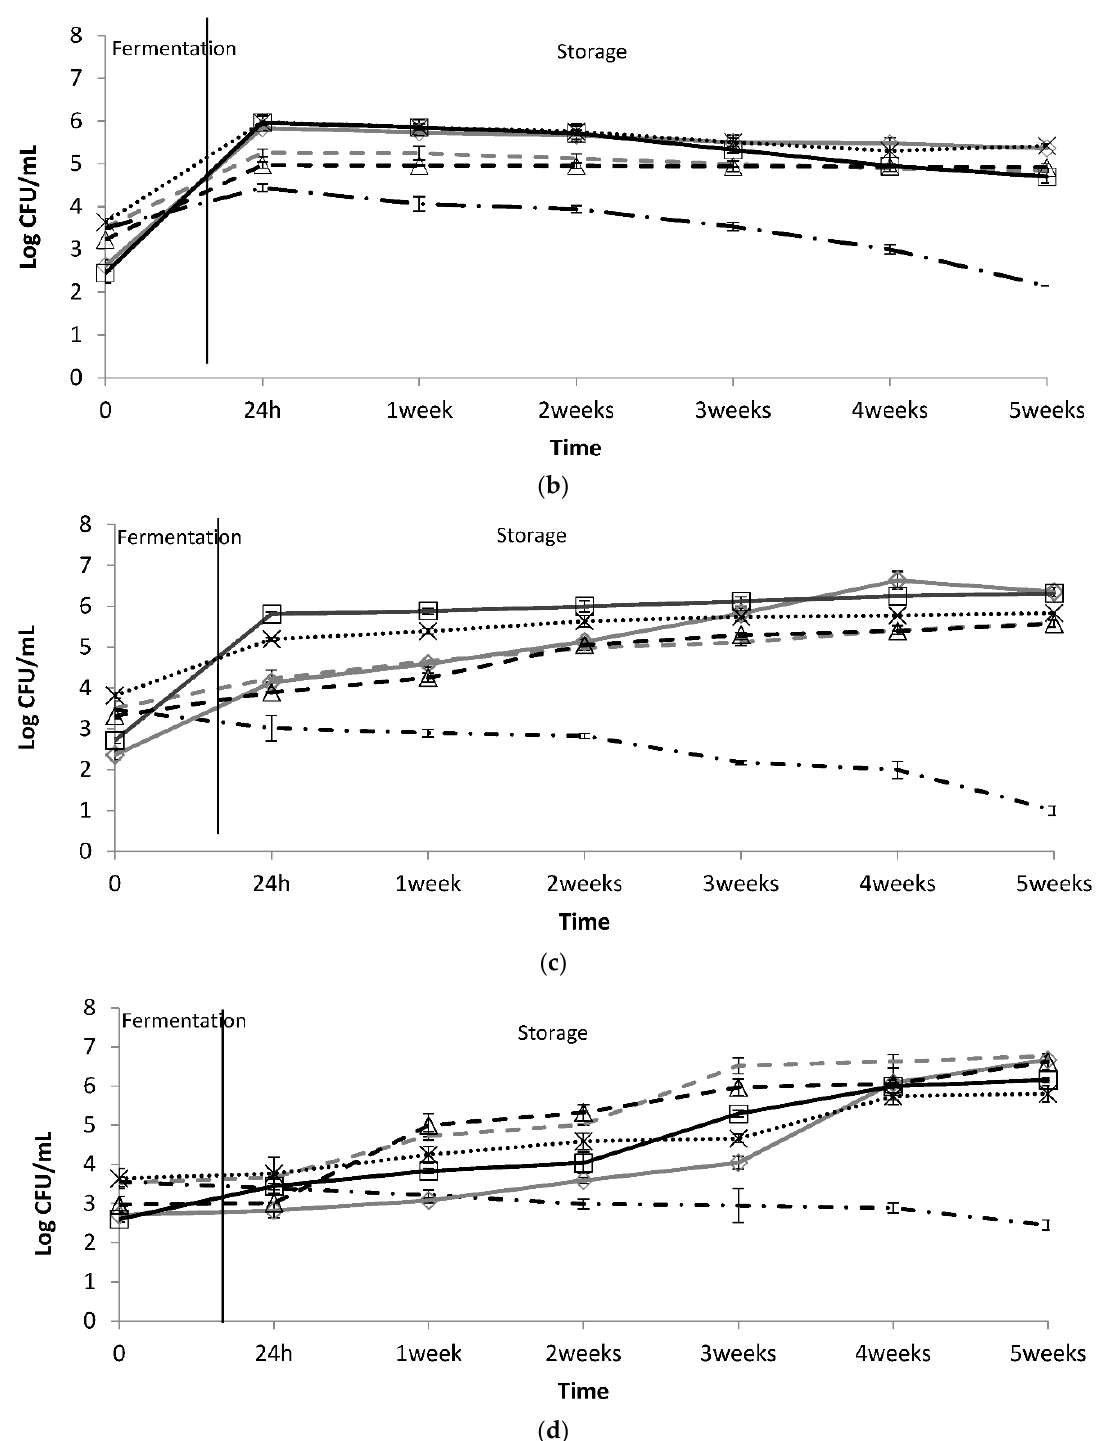
Figure 2. Growth kinetics of the yeasts during the second batch kefir fermentation and storage. ( a – d ) Graphs represent the behaviour of the yeasts in kefir obtained with whole cow’s milk, lac- tose-free cow’s milk, goat’s milk, and sheep’s milk, respectively. Each yeast tested was represented as follows: C. zeylanoides 13 ( ), D. hansenii 36 ( ), D. hansenii 78 ( ), K. lactis 80 ( ), Y. lipolytica 92 ( ), and the yeast consortium ( ), without distinction among the species. Data means ± standard deviations are represented as error bars. The remodulated concentrations of D. hansenii (increased), C. zeylanoides , and Y. lip- olytica (decreased) reflect an increase in the total concentration of yeasts in the consortium of approximately 2 log orders during the 24 h of fermentation; this concentration then remained constant during storage. The only exception was the sheep’s milk matrix, in which the total concentration of yeasts in the consortium remained constant with respect to the inoculum until the third week and then slowly increased until the end. 3.3. Analytical Characters and Fermentation By-Products of Different Kefir Fermented by the Improved Yeast Consortium–LbS The results of the chemical determinations of the kefirs fermented by the improved yeast consortium with LbS are shown in Table 2. After the period of storage, in each milk matrix used as a kefir fermentation substrate, single inoculated yeasts showed significant differences in lactose residue and lactic acid and acetic acid production compared with the control (only LbS). However, the production of each compound also varied among the different milks, while the pH value did not differ as a function of the yeasts or in the different types of milk. Ethanol was not detected in all trials. In cow’s milk, both D. hansenii strains (Dh 36 and Dh 78) and Y. lipolytica (Yl 92) showed higher residual values of lactose than the control, while C. zeylanoides (Cz 13) and K. lactis (Kl 80) showed the opposite behaviour when fermenting milk in pure culture with LbS. In contrast, in goat’s and sheep’s milks, all yeast strains in pure culture with LbS exhibited a higher residual value of this sugar than the control (LbS), with the only exception being D. hansenii 78 and Y. lipolytica , which showed an inconstant utilization of lactose and consequent lactic acid production. Without distinctions among milks, D. hansenii showed a general increase in lactic acid production, while contrary behaviour was shown by C. zeylanoides and K. lactis . The acetic acid concentration showed a general decrease (each yeast and each matrix), with the only exception being D. hansenii 78 in sheep’s milk. Within each milk matrix, the comparison between the yeast consortium and single pure cultures of yeast exhibited a constant trend: lactose reduction and lactic and acetic acid production showed significant differences in kefir fermented with the yeast consor- tium (Table 2).